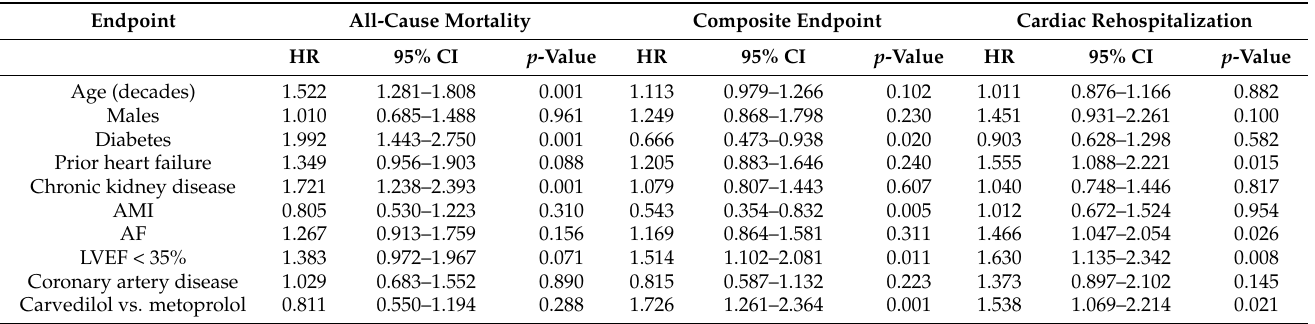
Table 3. Multivariable Cox regression analyses within the entire study cohort.